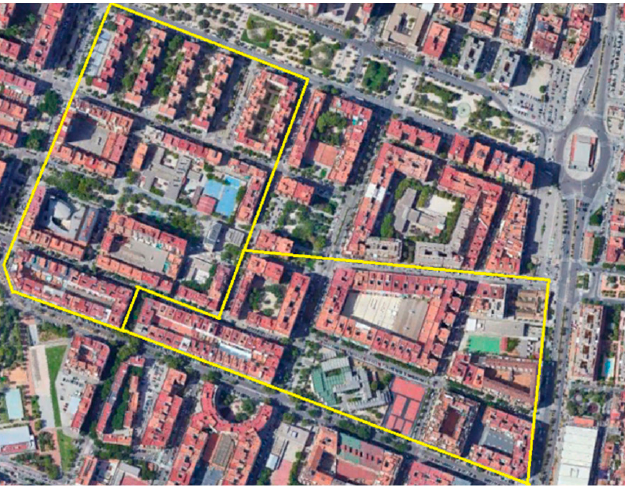
Figure 9. Alternative: possible fuel cell distribution.